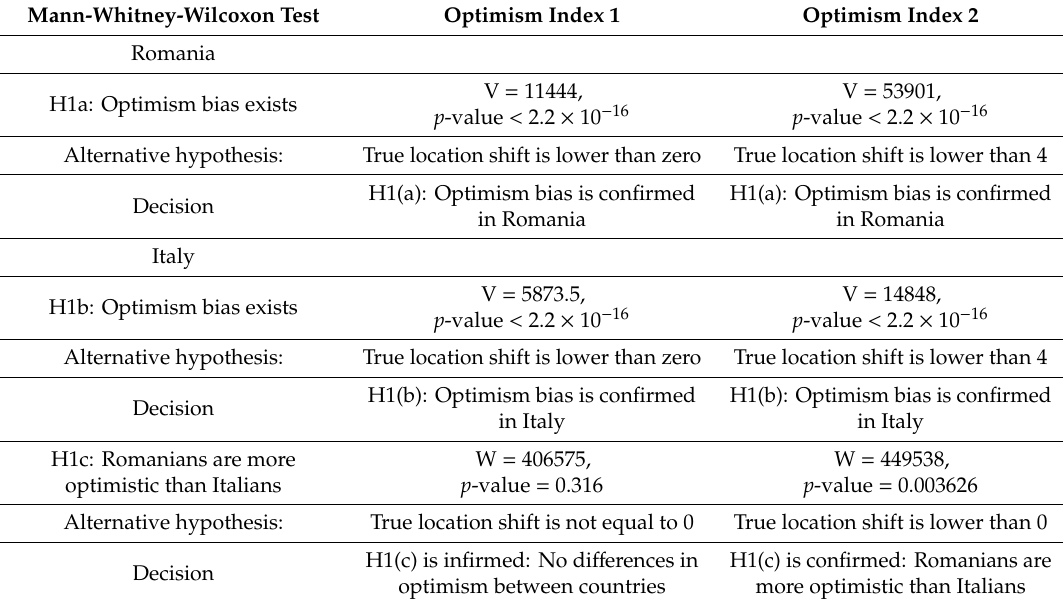
Table 5. Tests associated to the first research hypothesis,